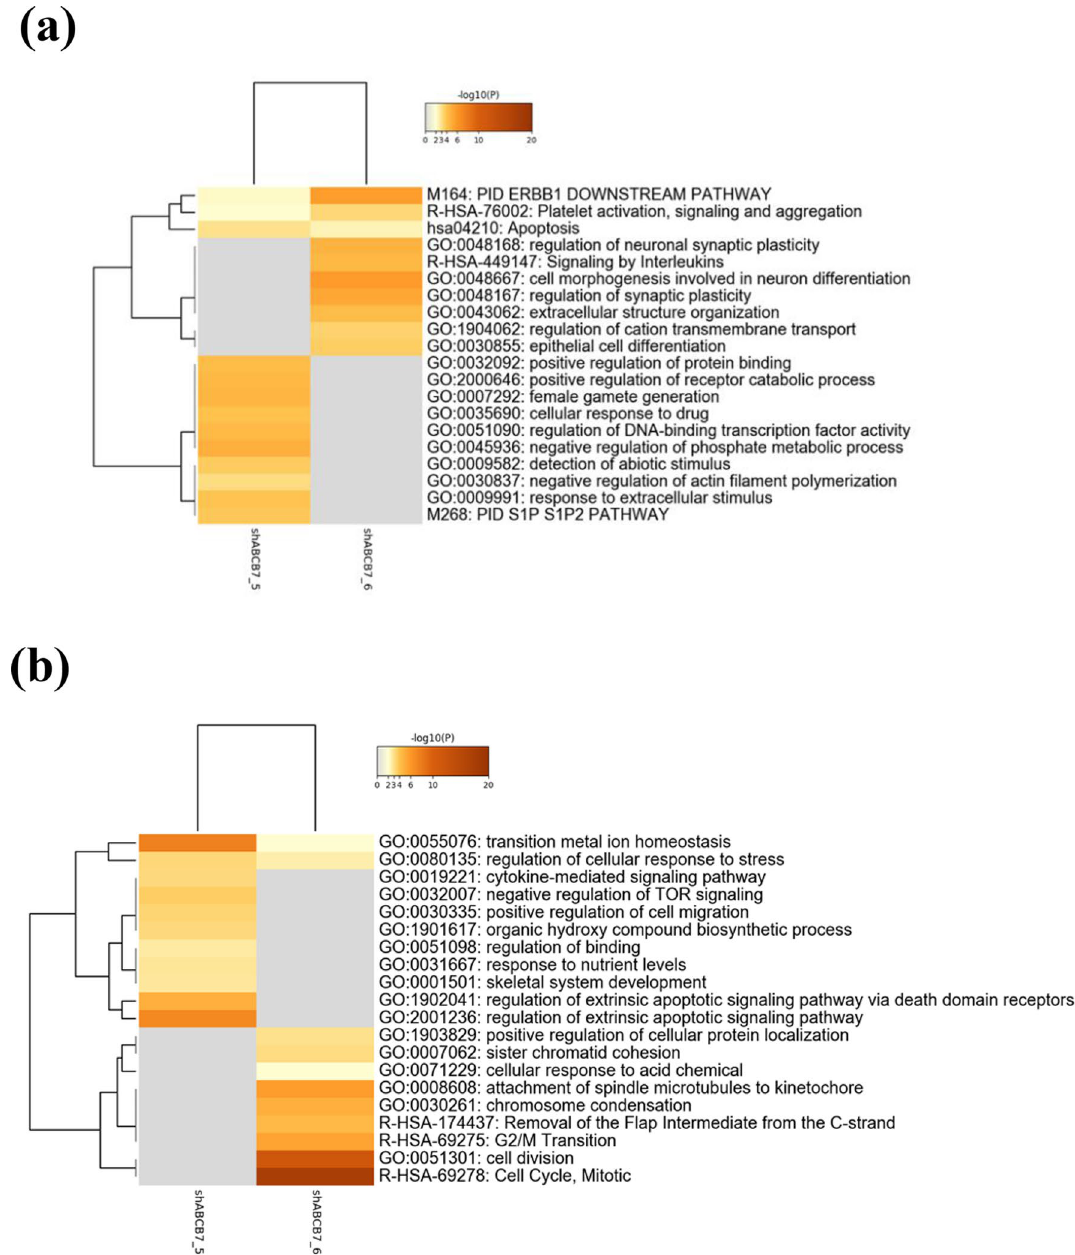
Figure 6. Gene ontology enrichment analysis of dysregulated genes in ABCB7 -knockdown HUDEP-2 cells. Enrichment heatmap of genes ( a ) upregulated and ( b ) downregulated by ABCB7 -knockdown. ABCB7 _shRNA5 and ABCB7 _shRNA6 indicate HUDEP-2 cells transduced with ABCB7 shRNA clone 5 and HUDEP-2 cells transduced with ABCB7 shRNA clone 6,